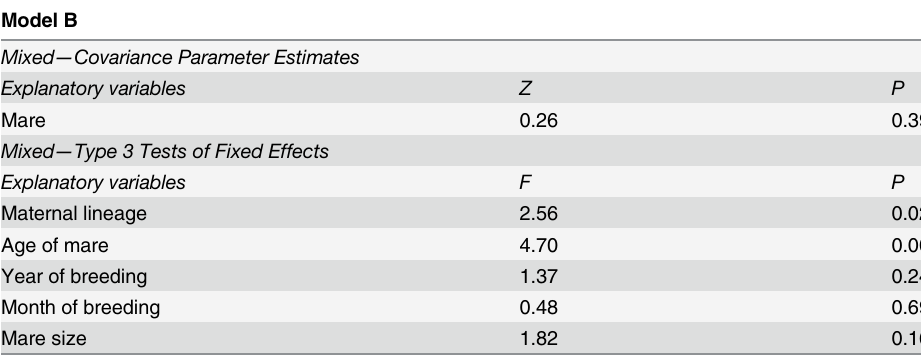
Table 3. Influence of different factors on foal sex ratio (n = 640 pregnancies) in Warmblood mares (n = 142). Model